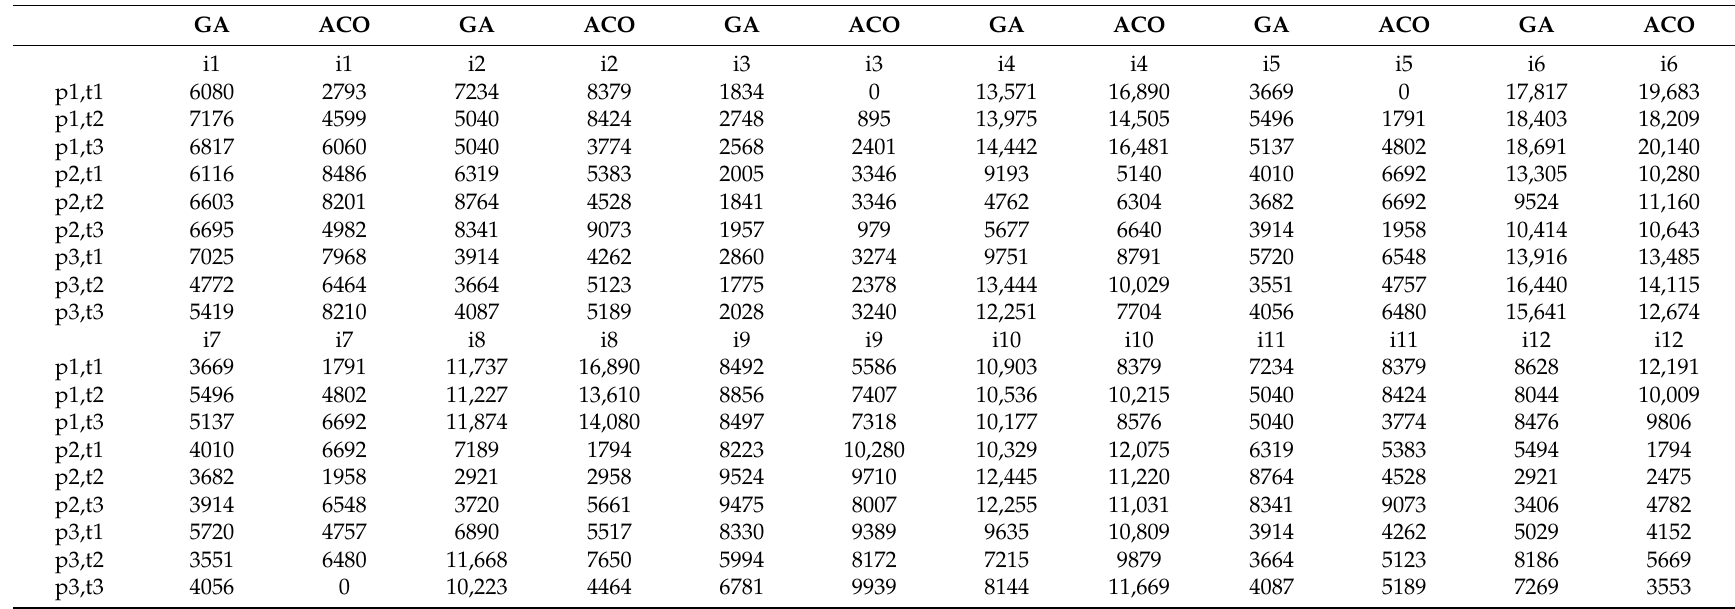
Table 6. Summary of results.